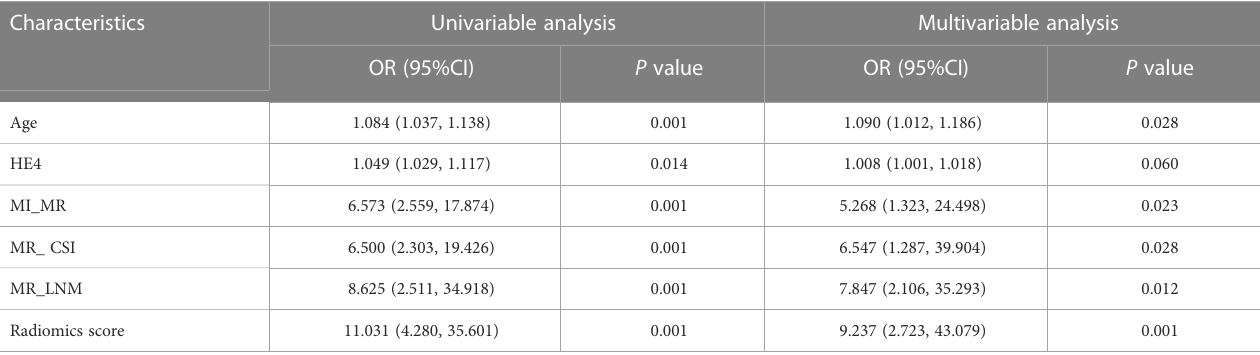
TABLE 2 Univariable and multivariable Logistic regression analyses results for high-grade EC.